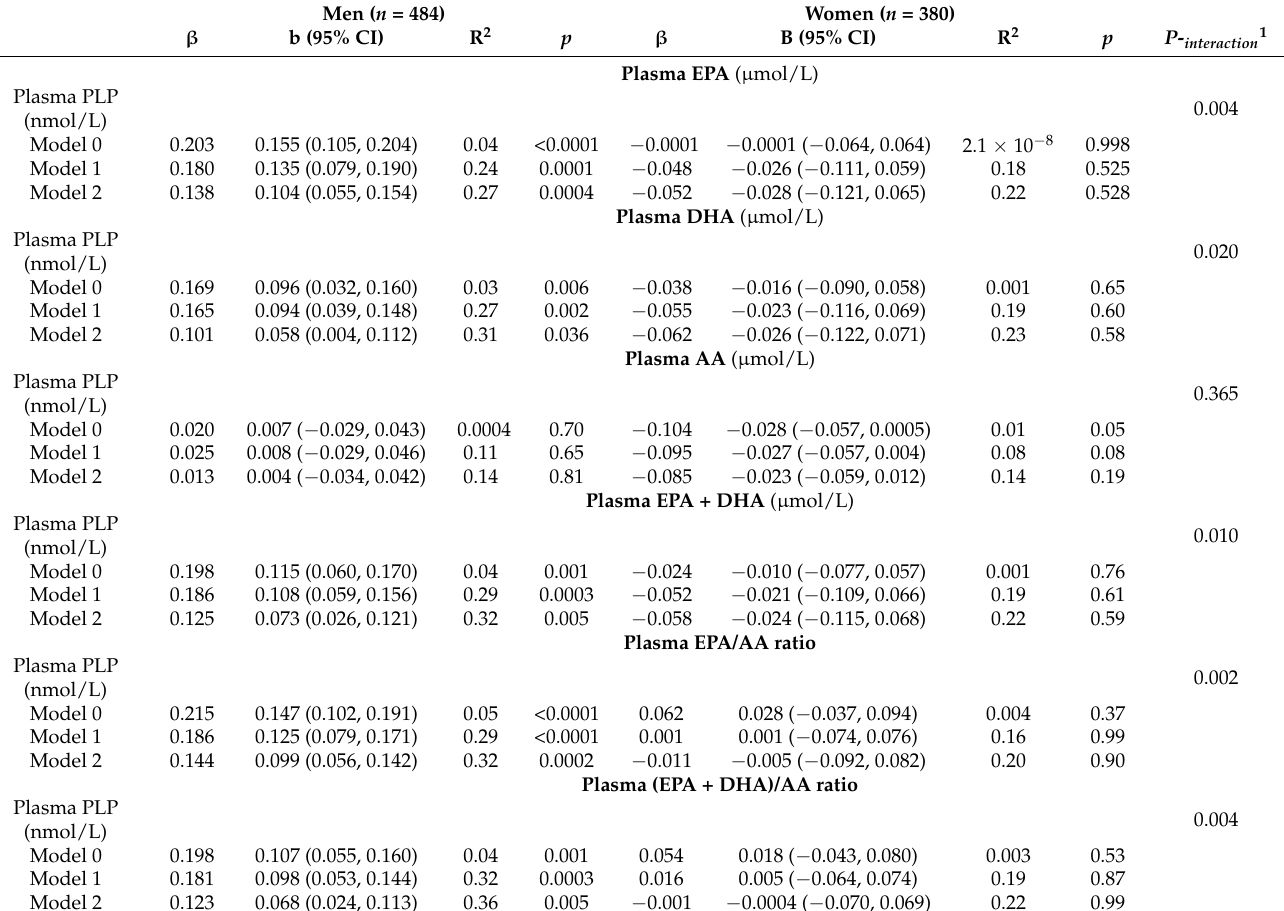
Table 3. Linear regression models: the association of plasma PLP concentration with plasma PUFA concentrations and ratios, stratified by gender among US adults aged 20–59 years, NHANES